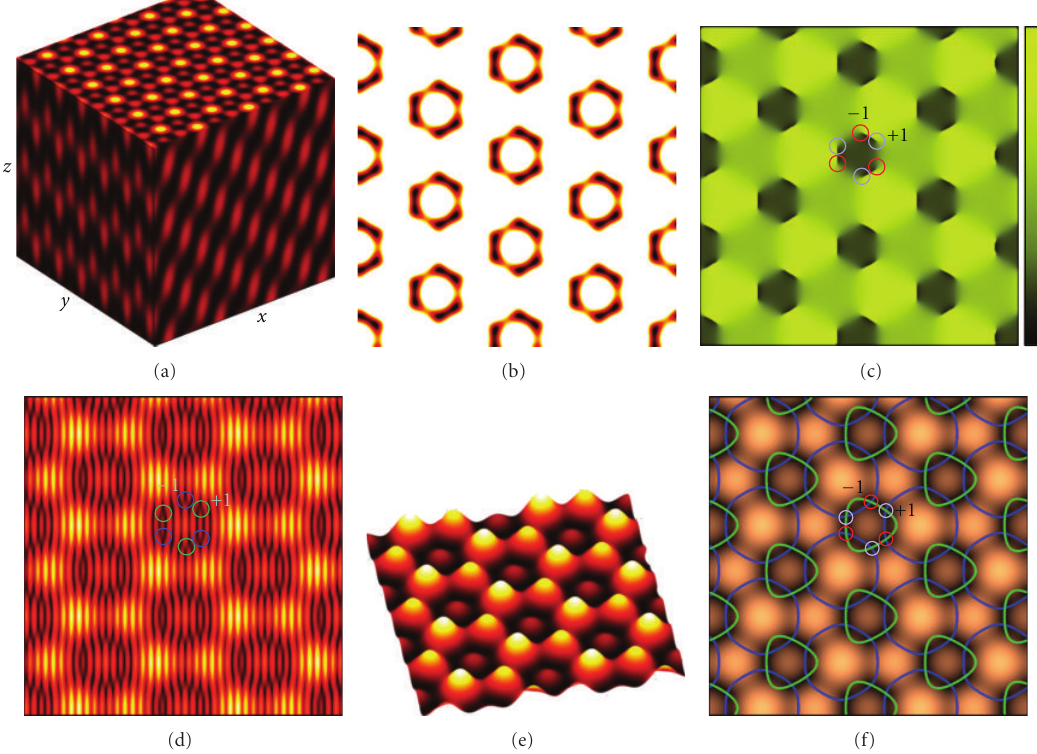
Figure 4: Analysis of vortices in a 3D photonic lattice formation by 3 + 1 noncoplanar beam interference. (a) 3D intensity distribution. (b) Intensity distribution of x - y plane with a lower threshold value in order to highlight the darker regions alone. (c) Phase profile. (d) The fork formation while the pattern is interfered with a plane wave launched at a large angle from the axis. (e) Intensity mesh plot. (f) Zero crossing plot (blue line: zeros of Re E ( r ) and green line: zeros of Im E ( r )).